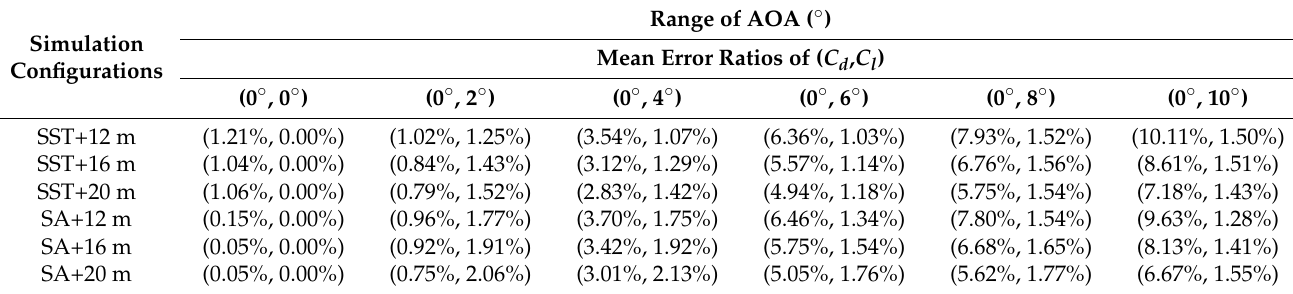
Table 13. The mean error ratios of C d and C l of the sharp trailing edge based on definition formula applying 400